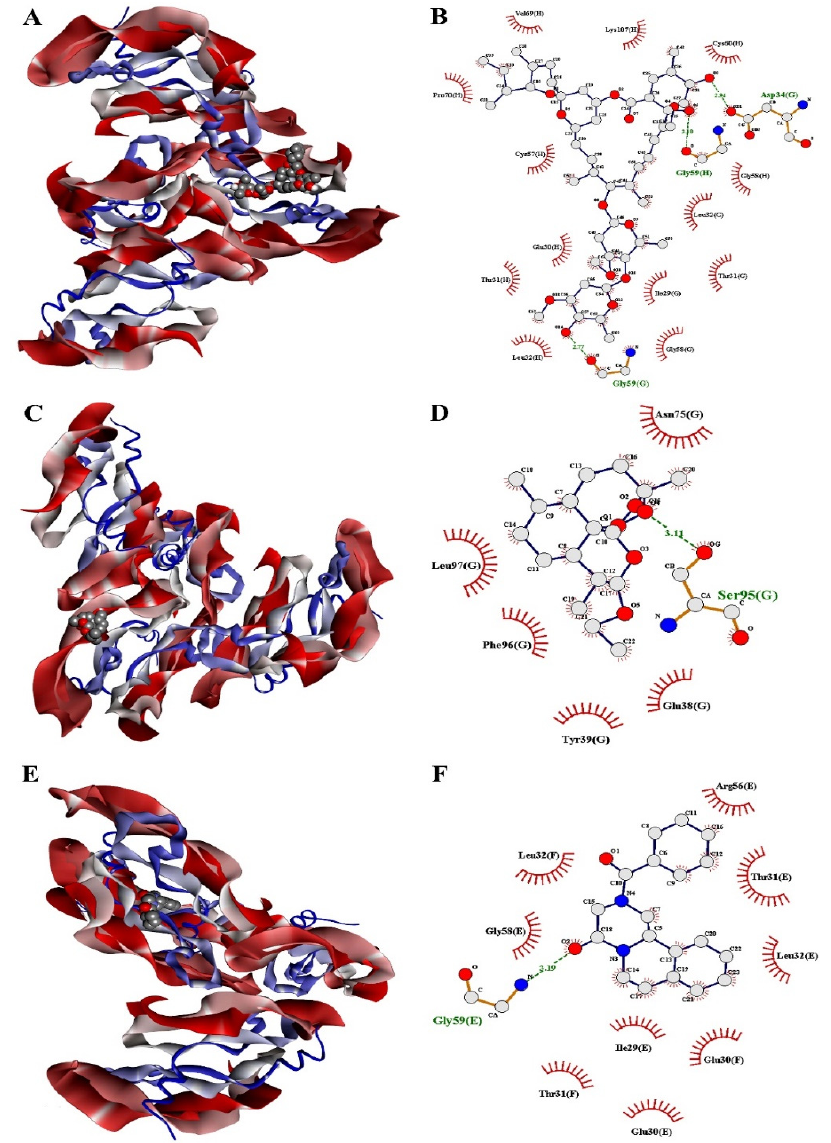
Figure 3. Three-dimensional and two-dimensional docked poses of VEGF–ligand complex for ( A , B ) ivermectin; ( C , D ) arteether; and ( E , F ) praziquantel.